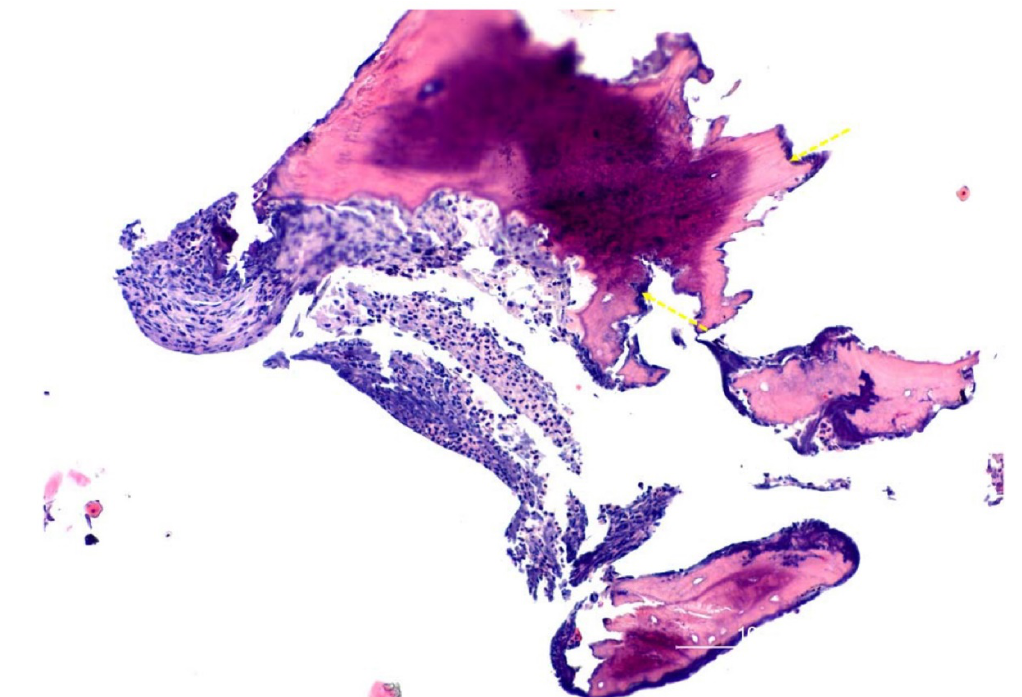
Figure 2: Hematoxylin and eosin-stained section at the bone interface: we can see inflammatory infiltrate and wide portions of residual necrotic bone (see the arrows).